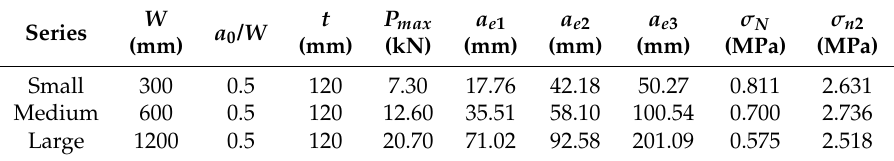
Table 2. Geometry, test results and equivalent crack length of compact tension specimens